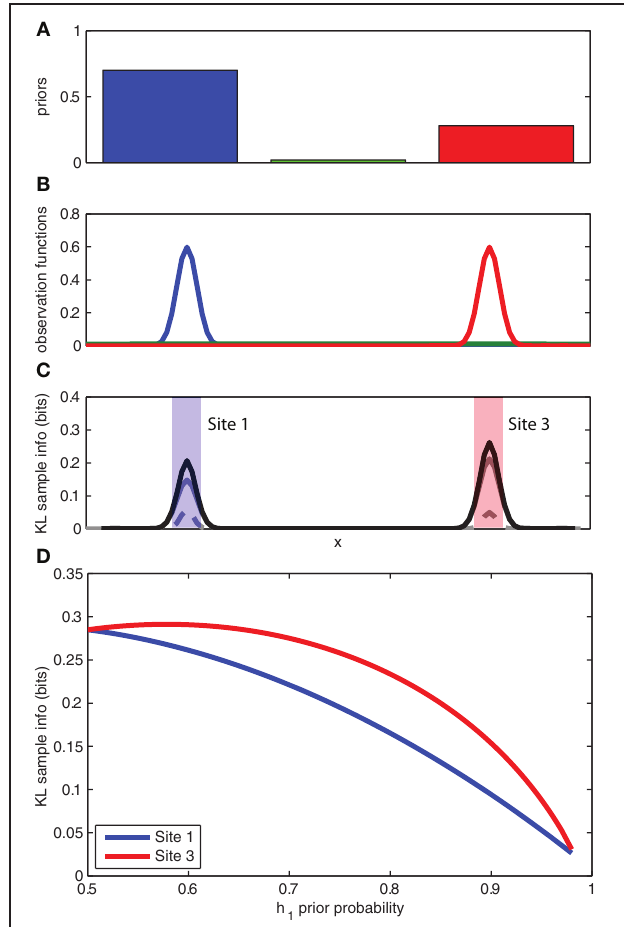
FIGURE 3 | Novelty preferences as information foraging. (A) The prior probabilities for the left, middle, and right locations. (B) The known observation functions for each of the three competing hypotheses for the location of the object. (C) The expected information gain as calculated by the KL divergence for a hit ( solid gray ), a miss ( broken gray ), and the sum ( black ). (D) The expected information gain (bits) for sampling at the left location (site 1) and the right location (site 3) as a function of the prior probability associated with the left location (site 1). See panel C for left and right locations. Note that expected information gain is higher at the site opposite to the higher prior